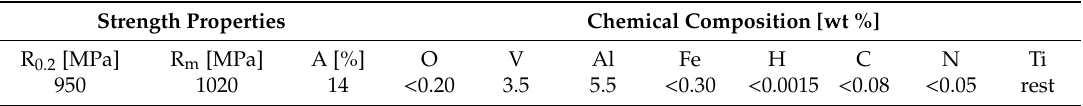
Table 2. Strength properties and chemical composition of the Ti6Al4V alloy.